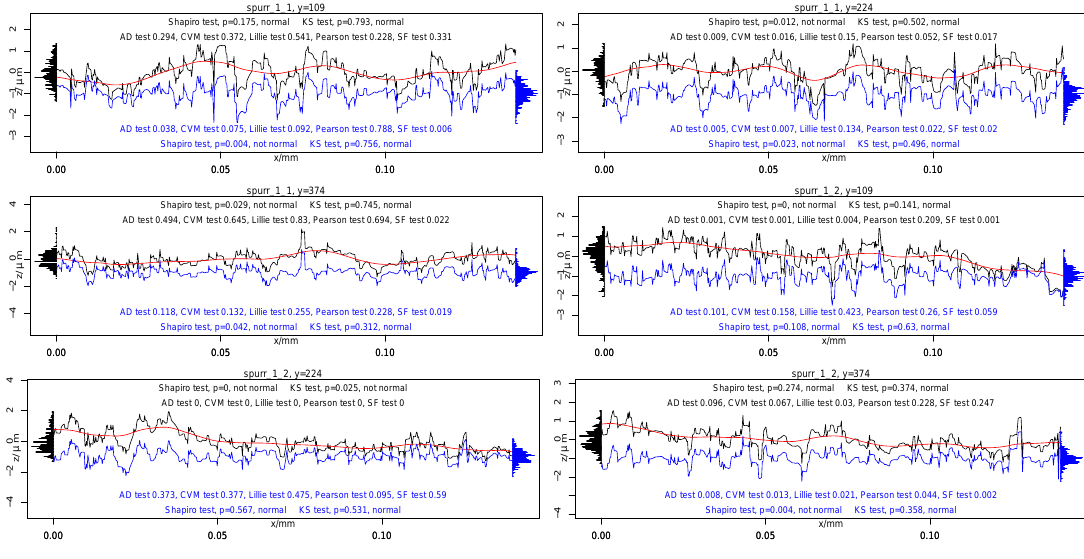
Figure 4. Roughness data of the tested surface with nominal asperity size 1 µ m. The meaning of notations is the same as in Figure